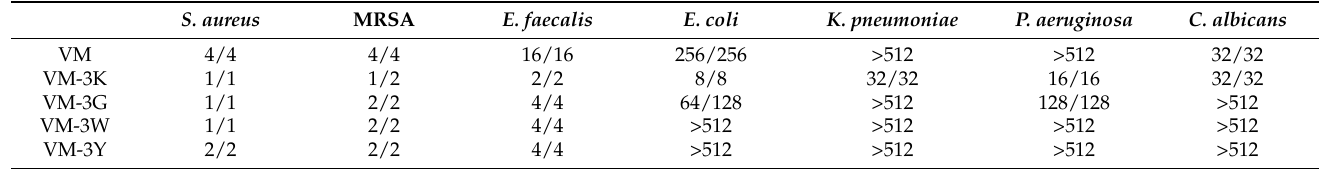
Table 4. MICs and MBCs of peptides and analogues against seven microorganisms (µM). Two mg/mL of amphotericin B for C. albicans and 2 mg/mL norfloxacin for six strains of Gram-positive and Gram-negative bacteria were used as the positive controls. Data were collected in nine replicates from three independent experiments.